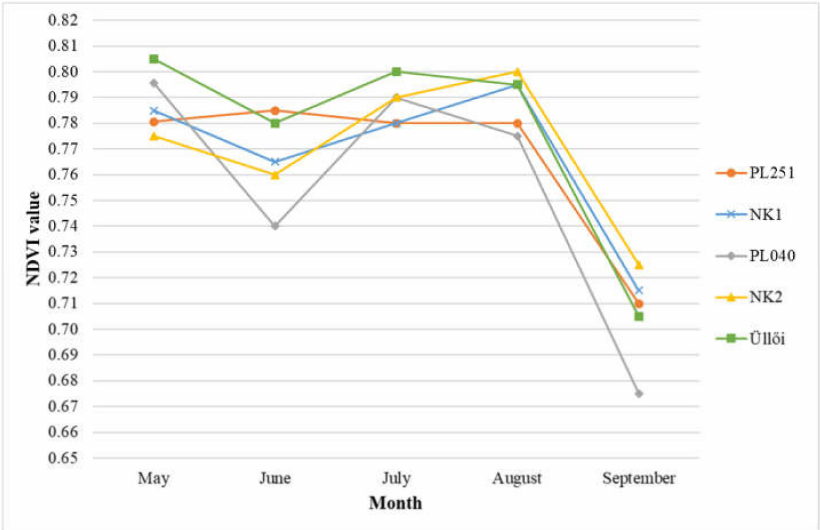
Figure 8. Normalized difference vegetation index (NDVI) values of black locust clones in the May- September period in